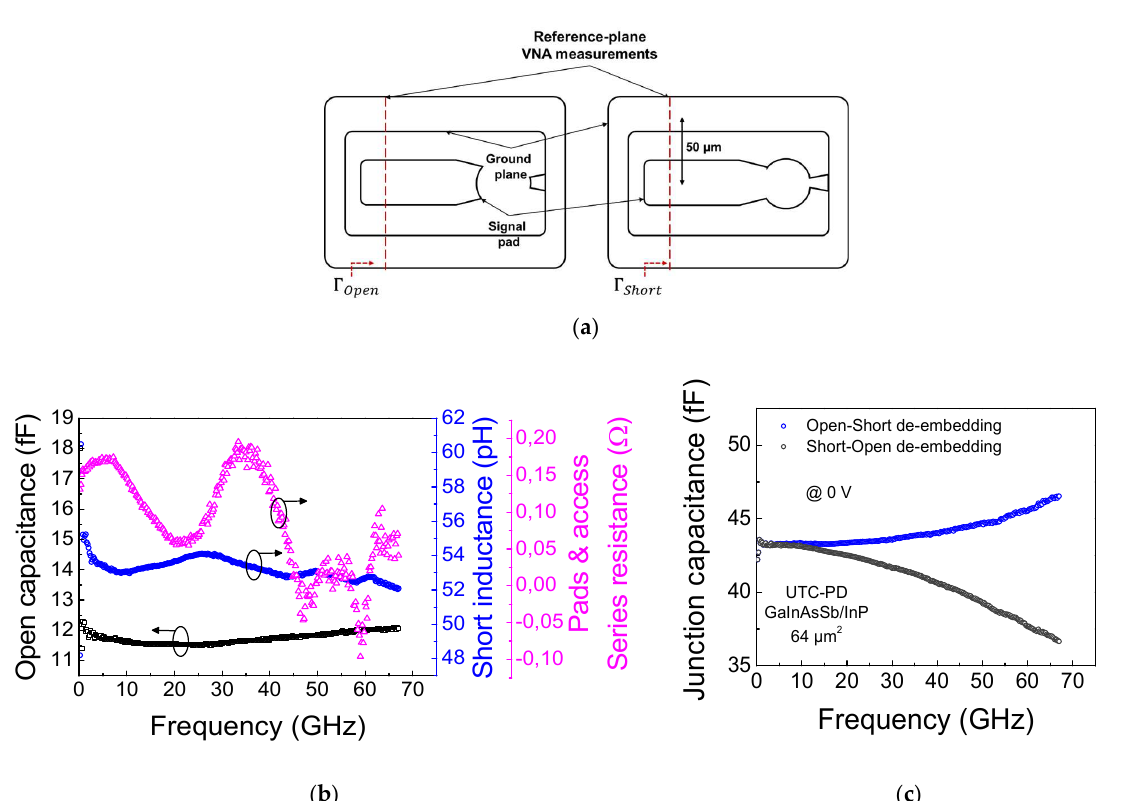
Figure 7. ( a ) Open and Short test structures; ( b ) Extraction of parasitic capacitance, inductance and resistance equivalents to the Open and Short test structures; ( c ) Extraction of the UTC-PD junction capacitance.